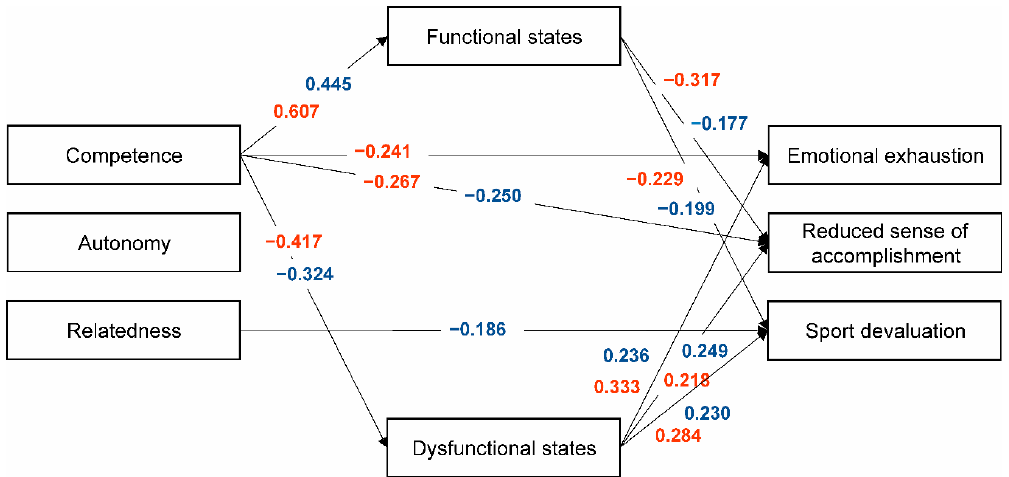
Figure 1. Path analysis results for the data of 13-15-year-olds. Only significant standardized estimates are presented ( p < 0.05) for girls (red) and boys (blue).